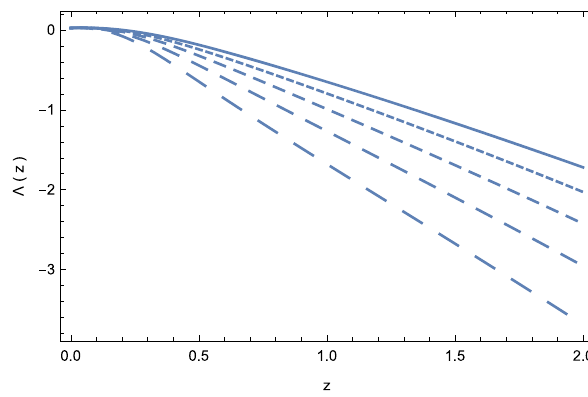
Fig. 12 Variation as a function of the redshift of the deceleration parameter q ( z ) for the geometry-matter coupling function F η e μ ˜ Q / 6 + ν ˜ T for M = 1 . 7, η = 6 /μ , ν = 20, and for different values of μ : μ = 1 . 7 (dotted curve), μ == 1 . 5 (short dashed curve), μ = 1 . 3 (dashed curve), μ = 1 . 1 (long dashed curve), and μ = 0 . 9 (ultra-long dashed curve). To integrate the system of cosmological evolution equa- tions we have used the initial conditions h ( 0 ) = 1, (cid:18)( 0 ) = 0 . 058, and (cid:4)( 0 ) = 0 . 0235. The solid curve represents the evolution of the deceleration parameter in the standard (cid:4) CDM cosmological model